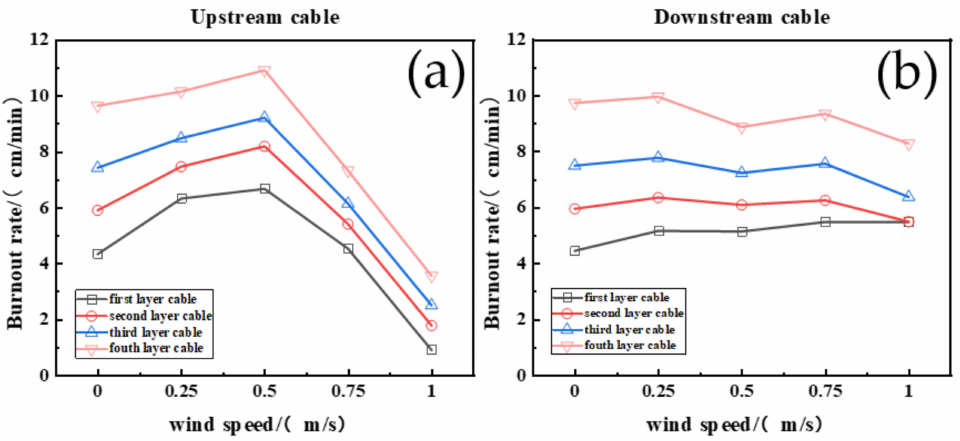
Figure 15. Cable burnout rate at different wind speeds: ( a ) Upstream cable; ( b ) Downstream cable. Upstream and downstream of the fire source, the temperature curve for different wind speeds is shown in Figure 16. Which shows that the temperature upstream of the fire source was significantly higher than that downstream of the fire source. Thus, the cables burn more vigorously and burn out faster upstream of the fire source. When the wind speed exceeds 0.50 m/s, the burnout speed of upstream cables declines sharply. Since the increased wind speed brings more oxygen supply, more heat and hot gases from the fire are carried out of the combustion zone by wind currents. The wind reduces heat accumulation and inhibits cable fire expansion. The downstream cables are affected less by wind speed. When the wind speed was 0.25 m/s, the downstream cable burnout rate increased slightly. When wind speed increased to 0.50 m/s, the upstream cables burned vigorously, consuming much of the oxygen in the air. The flue gas generated was blown downstream of the fire source, inhibiting the combustion of downstream cables. In summary, increasing ventilation will generate heat collecting obstacles on the upstream side of a fire source, accelerating the burning speed of the upstream cables. In addition, the burning rate of downstream cable also increases slightly. The burning rate of the overall cable was the fastest when wind speed was 0.50